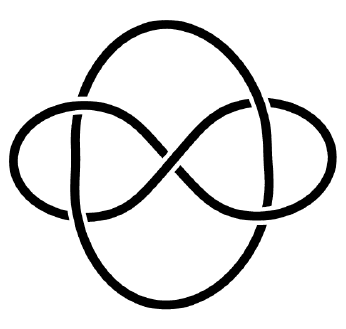
Figure 5. Whitehead link Wh